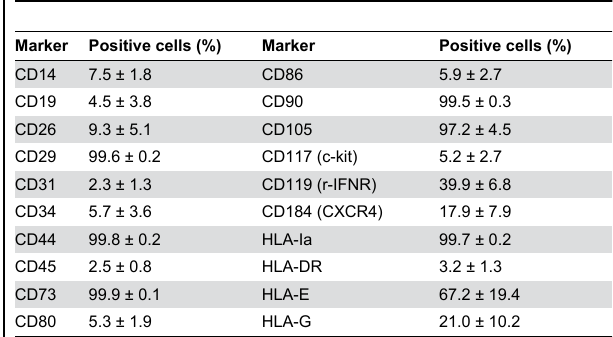
Table 2. The surface markers expressed on AFSCs.